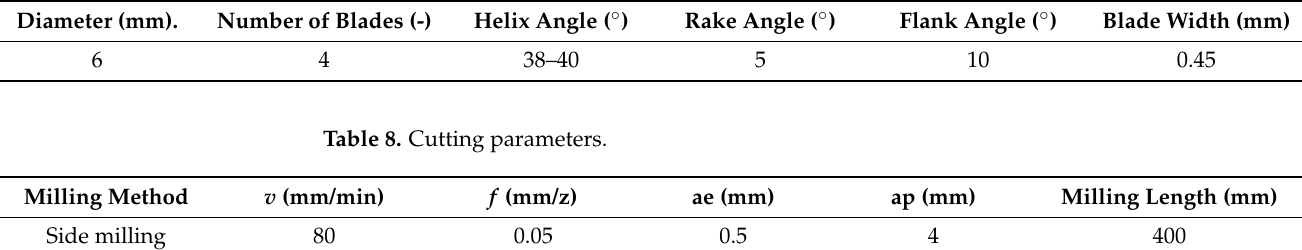
Table 4. Orthogonal scheme for the element diffusion experiment.